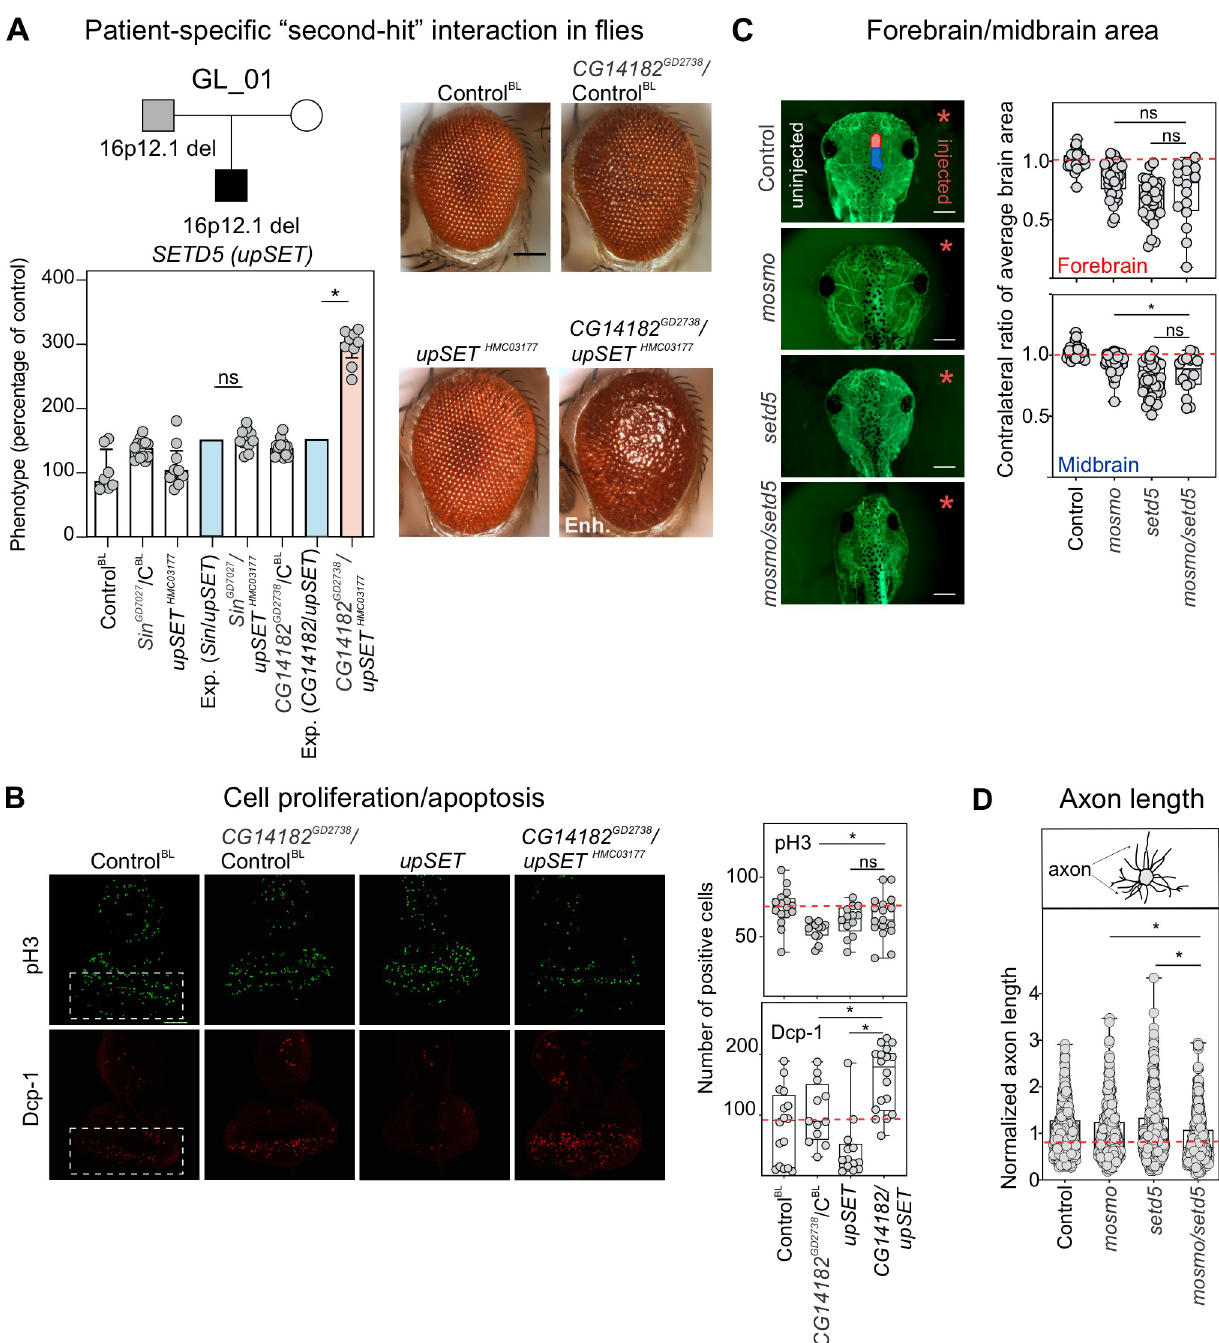
Fig 6. Homolog of SETD5 synergistically interacts with homolog of MOSMO to modify neurodevelopmental defects. ( A ) Pedigree of a family with 16p12.1 deletion, with the proband also carrying a de novo pathogenic mutation in SETD5 . Representative brightfield adult eye images for control and GMR-GAL4 knockdown of CG14182 GD2738 , upSET HMC03177 , and CG14182 GD2738 / upSET HMC03177 are shown. Data show a negative genetic interaction with simultaneous knockdown of CG14182 GD2738 and upSET HMC03177 . Bar plots show normalized phenotypes (median ± interquartile range) for recombinant lines of CG14182 GD2738 and Sin GD7027 crossed with background-specific control (Control BL , also represented as C BL ) or upSET HMC03177 . An aggravating phenotype is observed with CG14182 GD2738 / upSET HMC03177 (two-tailed one-sample Wilcoxon signed rank test with Benjamini-Hochberg correction, n = 9, � p = 0.018, in red) compared with expected (in blue). ( B ) Representative confocal images of third instar larval eye discs stained with anti-phosphorylated histone-3 (pH3, green) or anti-Dcp-1 (red), markers of cellular proliferation and apoptosis, respectively. Positive pH3 or Dcp-1 cells were quantified posterior to the morphogenetic furrow, indicated by white boxes in left panels. Double knockdown of CG14182 GD2738 / upSET HMC03177 led to increased pH3 (n = 17, two-tailed Mann-Whitney, � p = 0.046) and Dcp-1 (n = 19, � p = 0.006) positive cells compared to knockdown of CG14182 GD2738